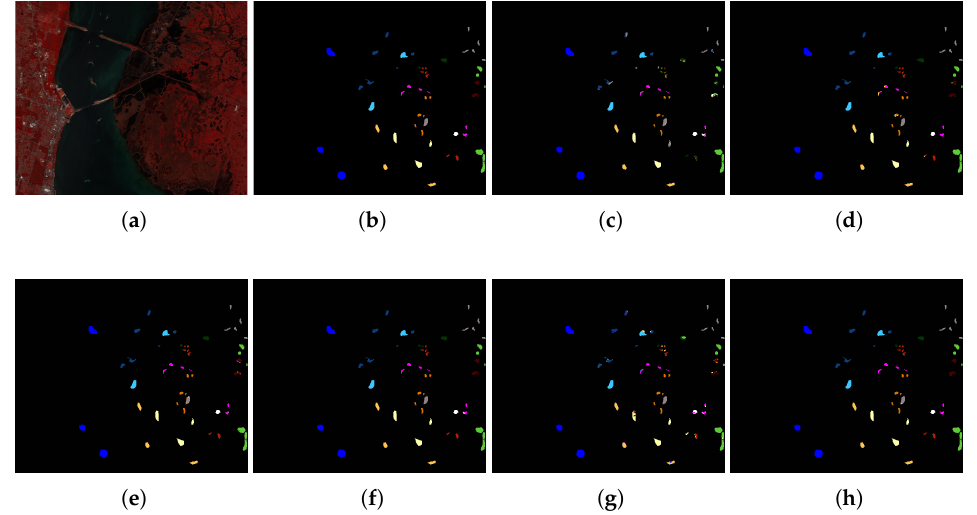
Figure 8. The classification map of KSC dataset. ( a ) False color image, ( b ) Ground truth, ( c – h ) Prediction classification maps of 3D-CNN (82.21%), SSLSTMs (97%), SSUN (97.10%), SSRN (99.27%), HybridSN (87.46%), and our proposed architecture